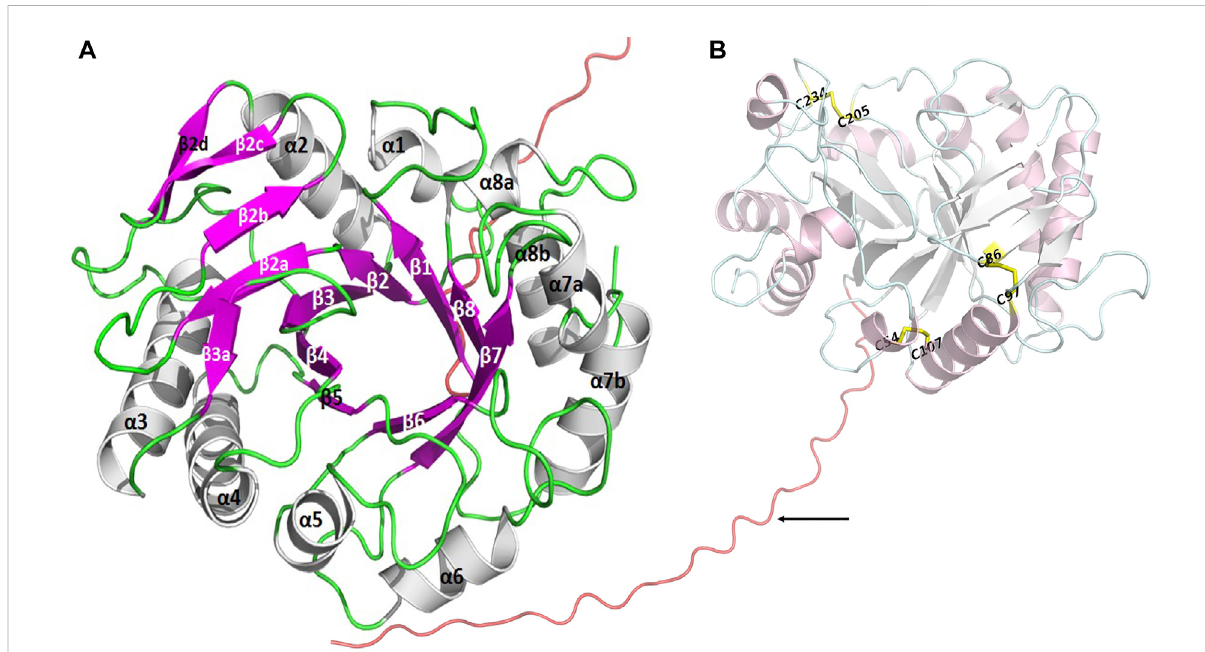
FIGURE 1 The tertiary structure of Af ChiJ was predicted by AlphaFold2. (A) Af ChiJ consisted of a ( β / α ) 8 TIM barrel fold with an additional α / β structural domain, the additional α / β structural is composed of four antiparallel β -strands, inserted in the loop connecting helix α 2 and barrel chain β 2. (B)